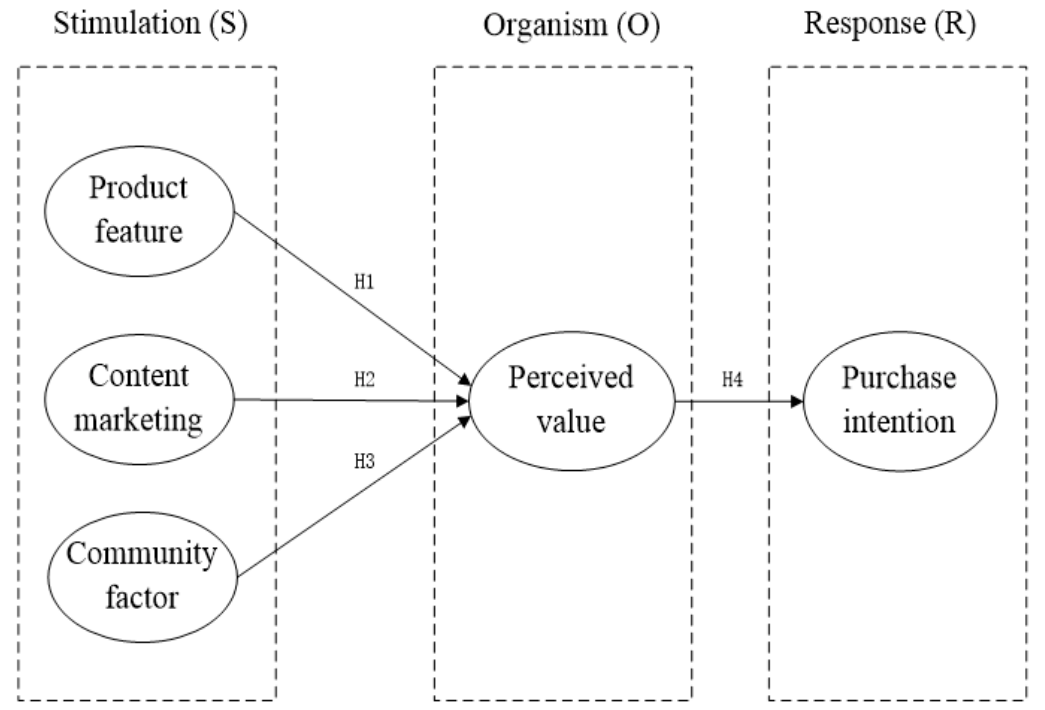
Figure Figure 2. The Model of Factors Affecting Consumers’ Purchase Intentions on Community E-com- merce Platform.